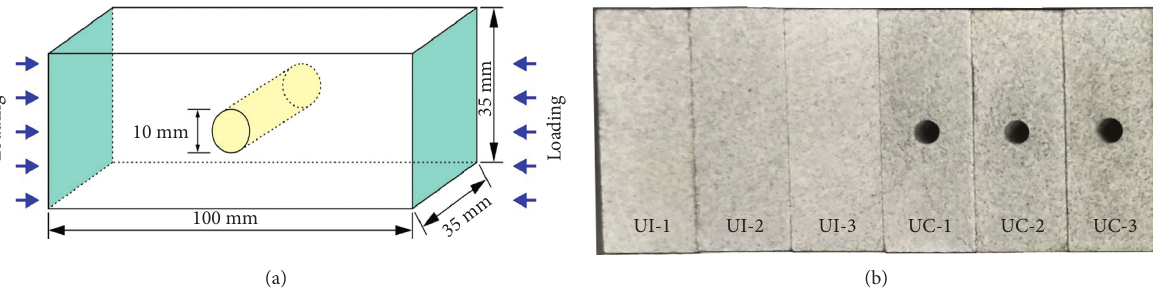
Figure 1: Specimen model and size of the intact sample containing an opening (a) and physical photos of the test samples